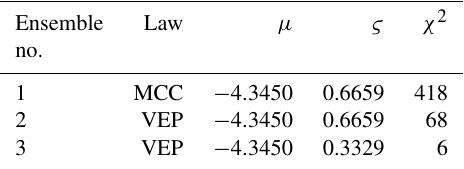
Figure 1. Forecast state ensemble (grey lines), i.e. relative vertical displacements u z in time, for the MCC (a) and the VEP (b) behavior and available relative GPS records (blue line). The actual displace- ments are normalized with respect to the last GPS record available. The associated probability distributions and χ 2 values are provided in the first two rows of Table 1. Table 1. Analyzed ensembles with their associated constitutive laws, parameters ( µ and ς ) of the probability distribution of λ ∗ and χ 2 values.